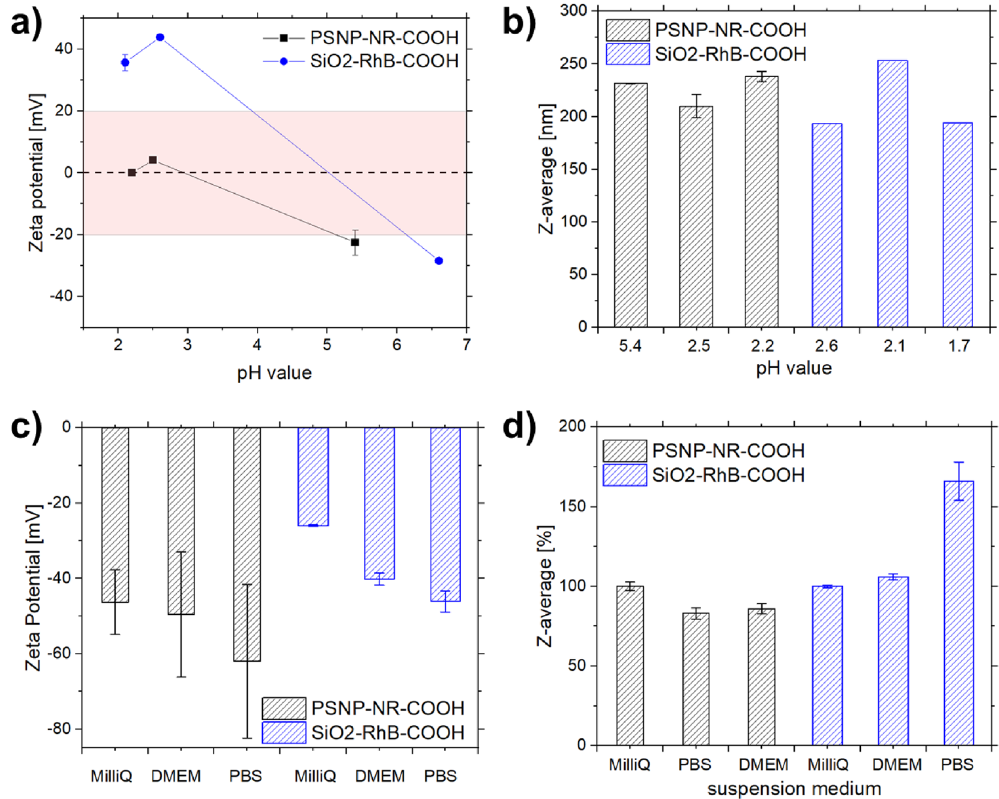
Figure 6. Overview of the results of the stability studies with carboxylated and dye stained PSNPs and SiO 2 - NPs utilizing zeta potential and DLS measurements at various pH values ( a , b ) and in different dispersion media ( c , d ).